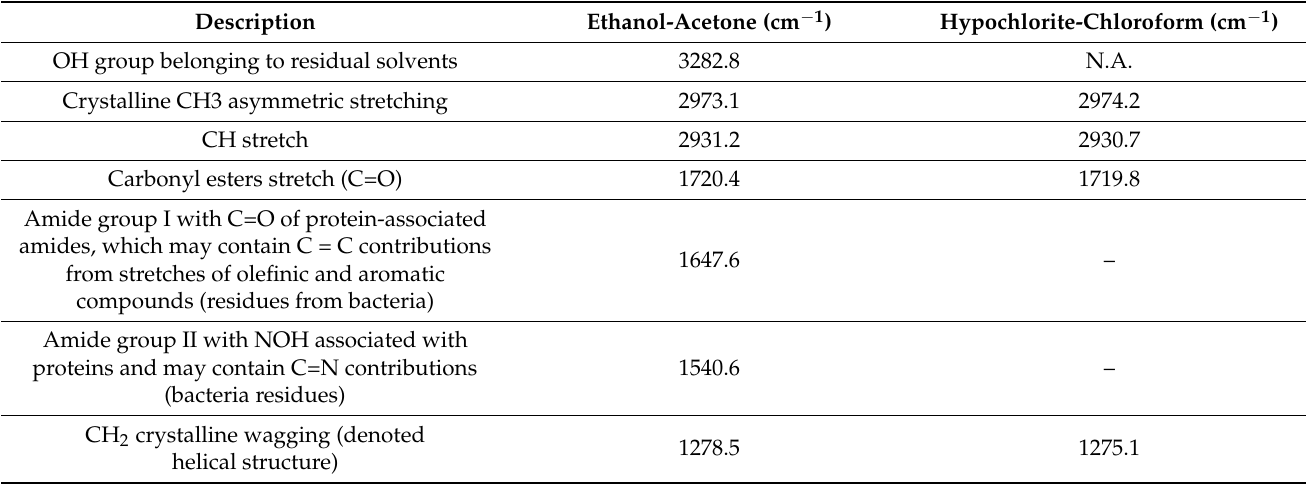
Table 2. Identification of peaks present in the P3HB samples recovered by the two rupture and extraction methods.